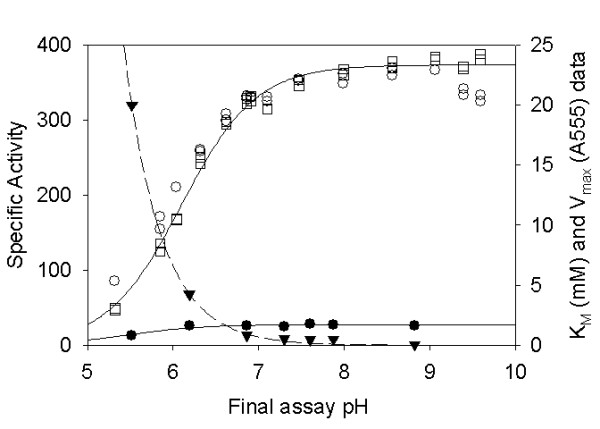
pH Rate Profile. The pH rate profile is presented at 10 mM ALA in BTP-HCl in the presence (○) and absence (□) of 0.1 M KCl. Protein was 15 μg ml-1. The Km (filled tringle) and Vmax (filled circle) values as a function of pH at (0.15 μg ml-1) are given in units of mM and A555, respectively.